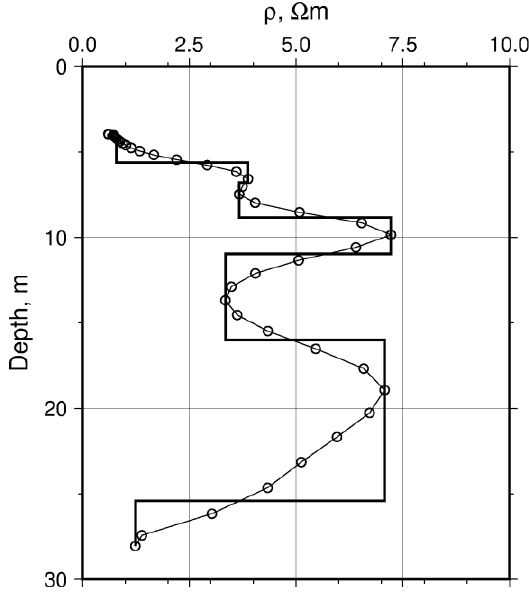
Figure 2. Resistivity with depth (empty circles) obtained by the thin sheet approximation transformation and the layered 1D model of resistivity cross section (solid line) obtained on the basis of the first curve.